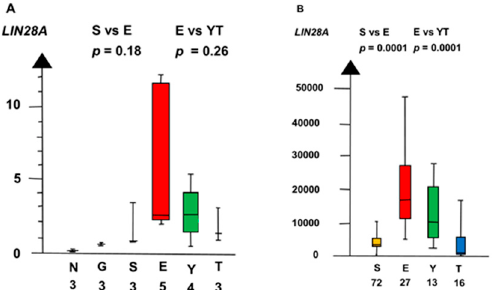
Figure 10. RNA expression of LIN28A in the second microarray and the RNAseq dataset ( A , B ) show that embryonal carcinoma (E) had a high RNA expression and that yolk sac tumor (Y), and teratoma (T) had a low RNA expression.